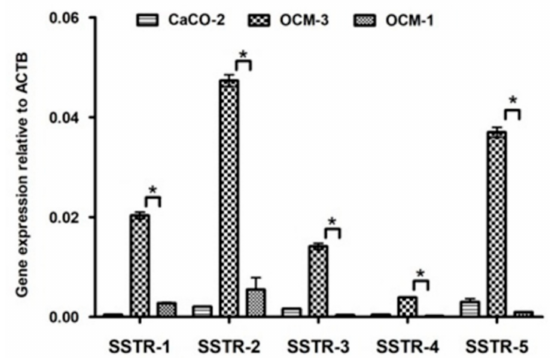
Figure 3. Expression of SSTR-1-5 in OCM-1, OCM-3 human uveal melanoma cell lines and in CACO-2 human Caucasian colon adenocarcinoma cell lines. qRT-PCR results show that SSTR-1, -2, -3, -4, -5 are expressed in both human UM cell lines examined. CACO-2 cell line was used as a positive control. The p value obtained by GraphPad Prism—one-way ANOVA test was considered to be significant (* p < 0.0001).